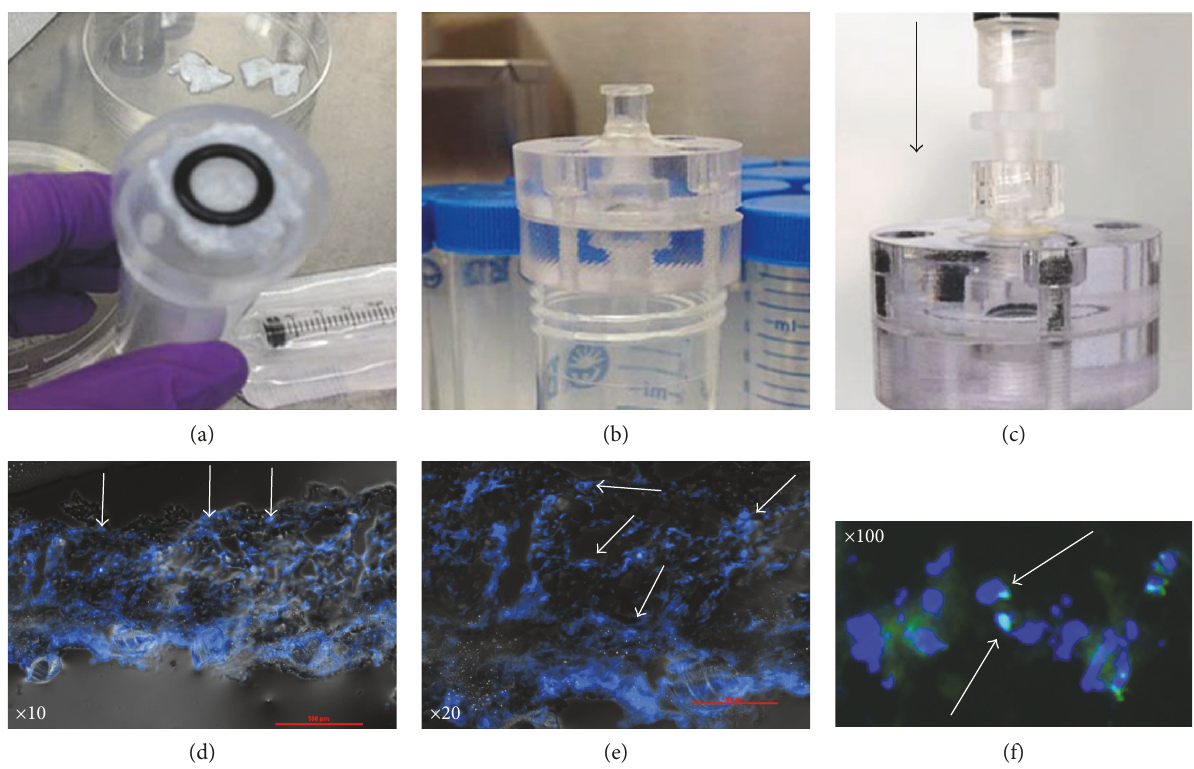
Figure 6: The process of cellular infusion in vitro. (a) A decellularized ECM sca ff old is placed onto the top of an infusion chamber. (b) Position and fi x ECM sca ff old. (c) Begin infusing donor cells with culture medium into a decellularized ECM sca ff old. (d, e) Histological analysis of cell distribution into sca ff old by using DAPI staining. (f) Distribution test of fl uorescent GFP-labeled donor cells in the ECM sca ff old after completing infusion.